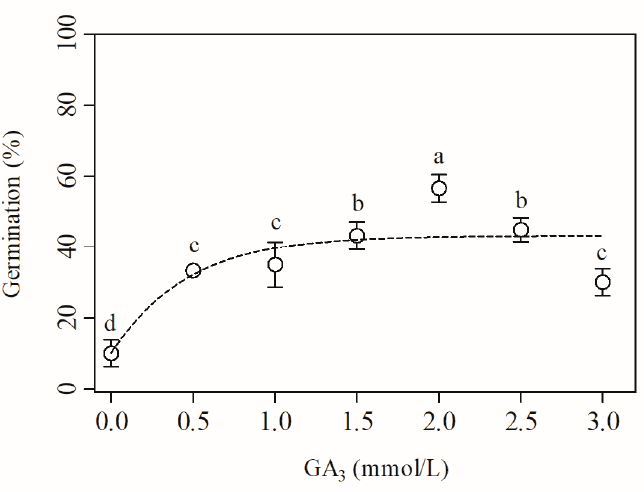
Figure 6. Effect of GA 3 on the dormancy release and germination of intact E. ulmoides seeds. The seeds were treated with different concentrations of GA 3 for 24 h, incubated in the dark at 10 ◦ C for 30 days, and then the germination percentage was calculated (mean ± standard error). Each treatment had four replicates and 30 seeds were used for each replicate.There are no significant differences between the data labeled with the same lower case letters ( p = 0.05).